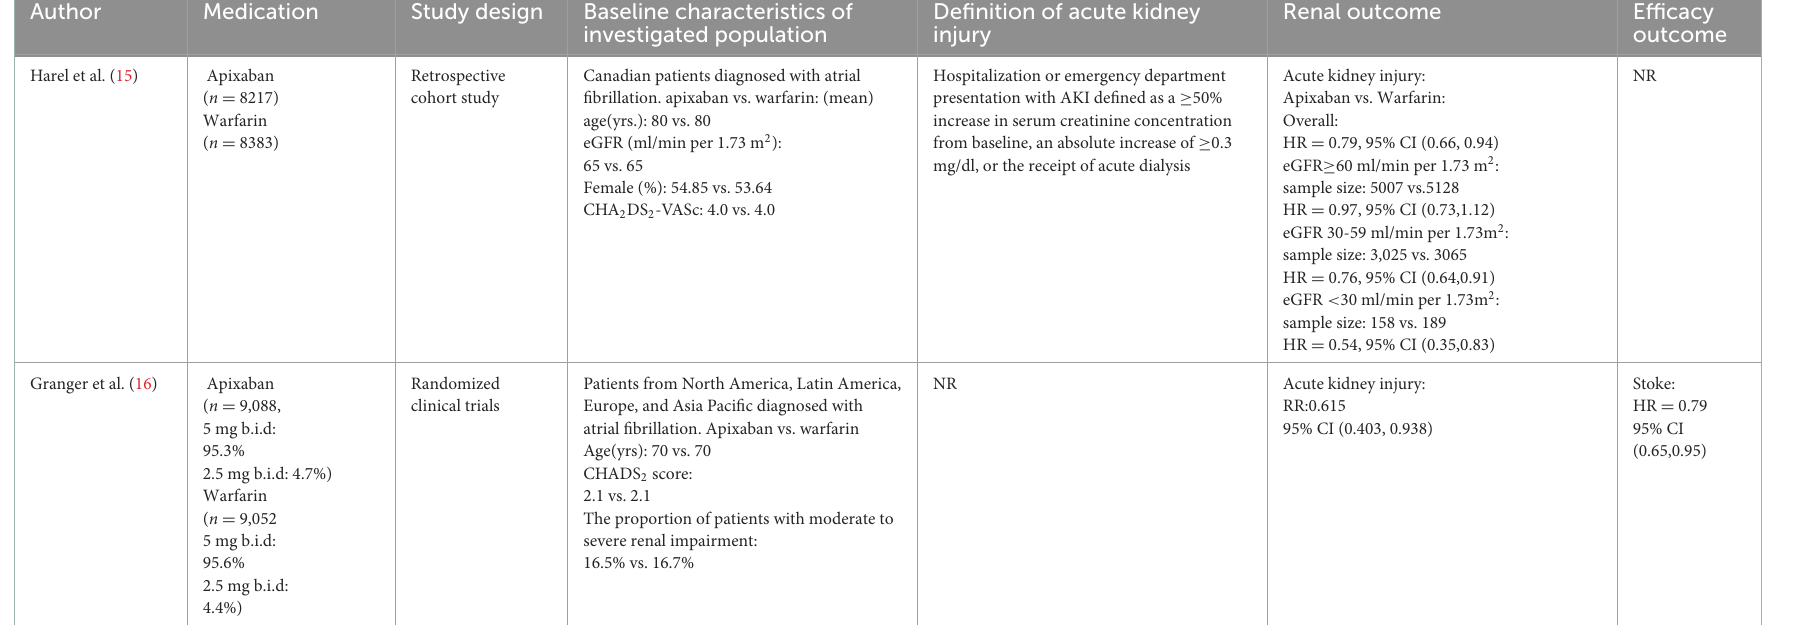
Acute kidney injury: Apixaban vs. Warfarin: Overall: HR = 0.79, 95% CI (0.66, 0.94)